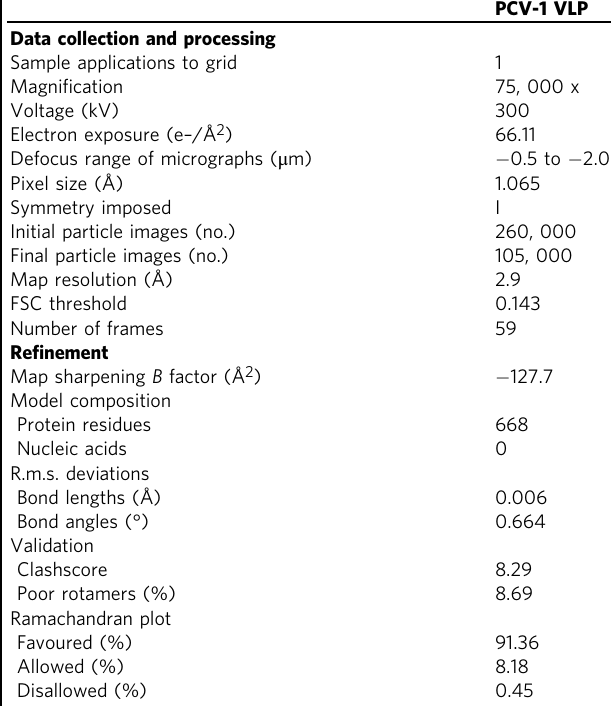
Table 1 Cryo-EM data collection, re fi nement and validation